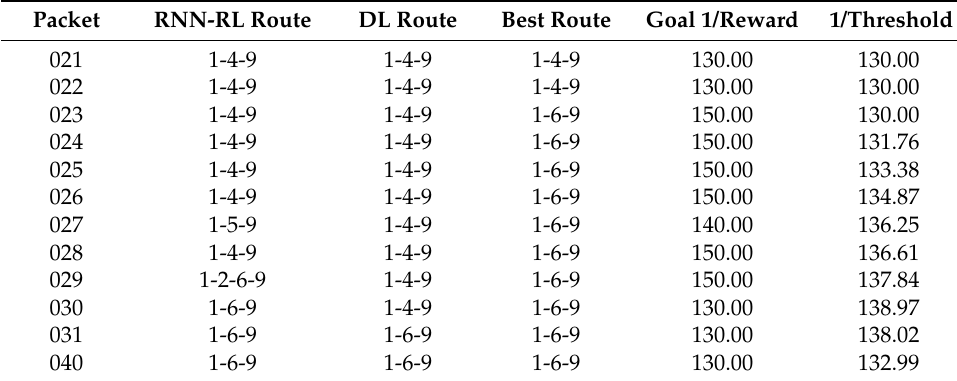
Table 6. Goal: 1 × Delay (3 × 3 Nodes).